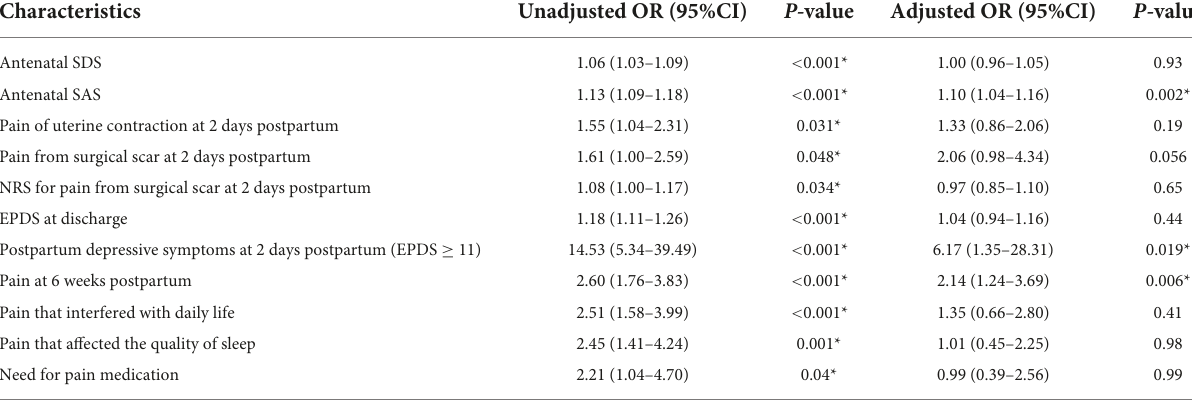
TABLE 3 Risk factors for PPD in women who underwent elective